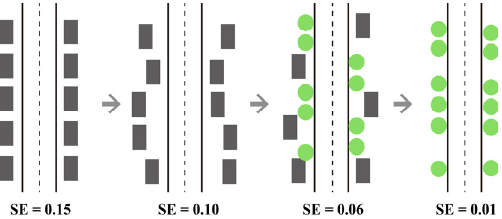
Figure 10. Variation of spatial enclosure (SE) with different building density and arrangement.